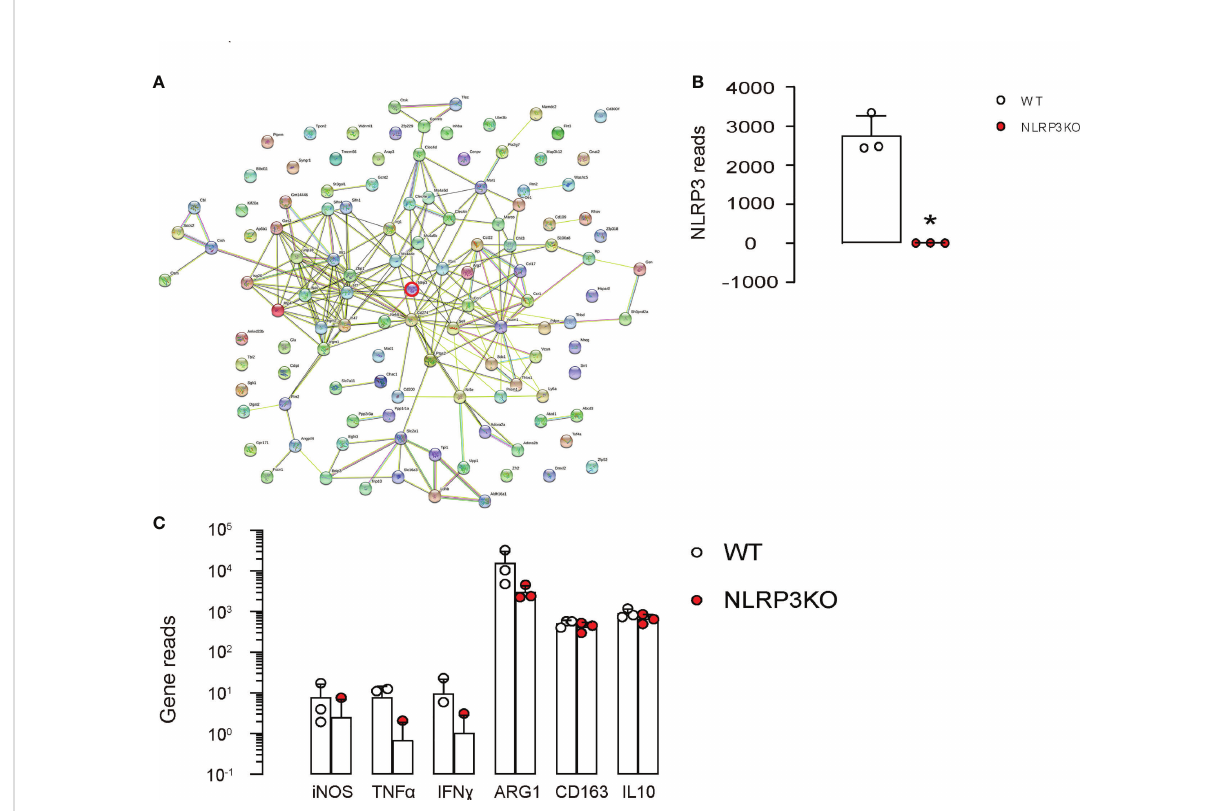
FIGURE 4 NLRP3 depletion in macrophages alters genes associated with macrophage phenotype. (A-C) A GEO database GSE183698 was used to analyzed gene pro fi le from mouse macrophages with or without NLRP3 depletion (NLRP3KO, WT). (A) Genes associated with fi ne determination